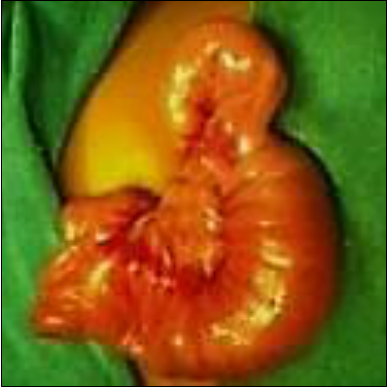
Figure 1: Jejunoileal intussusception.